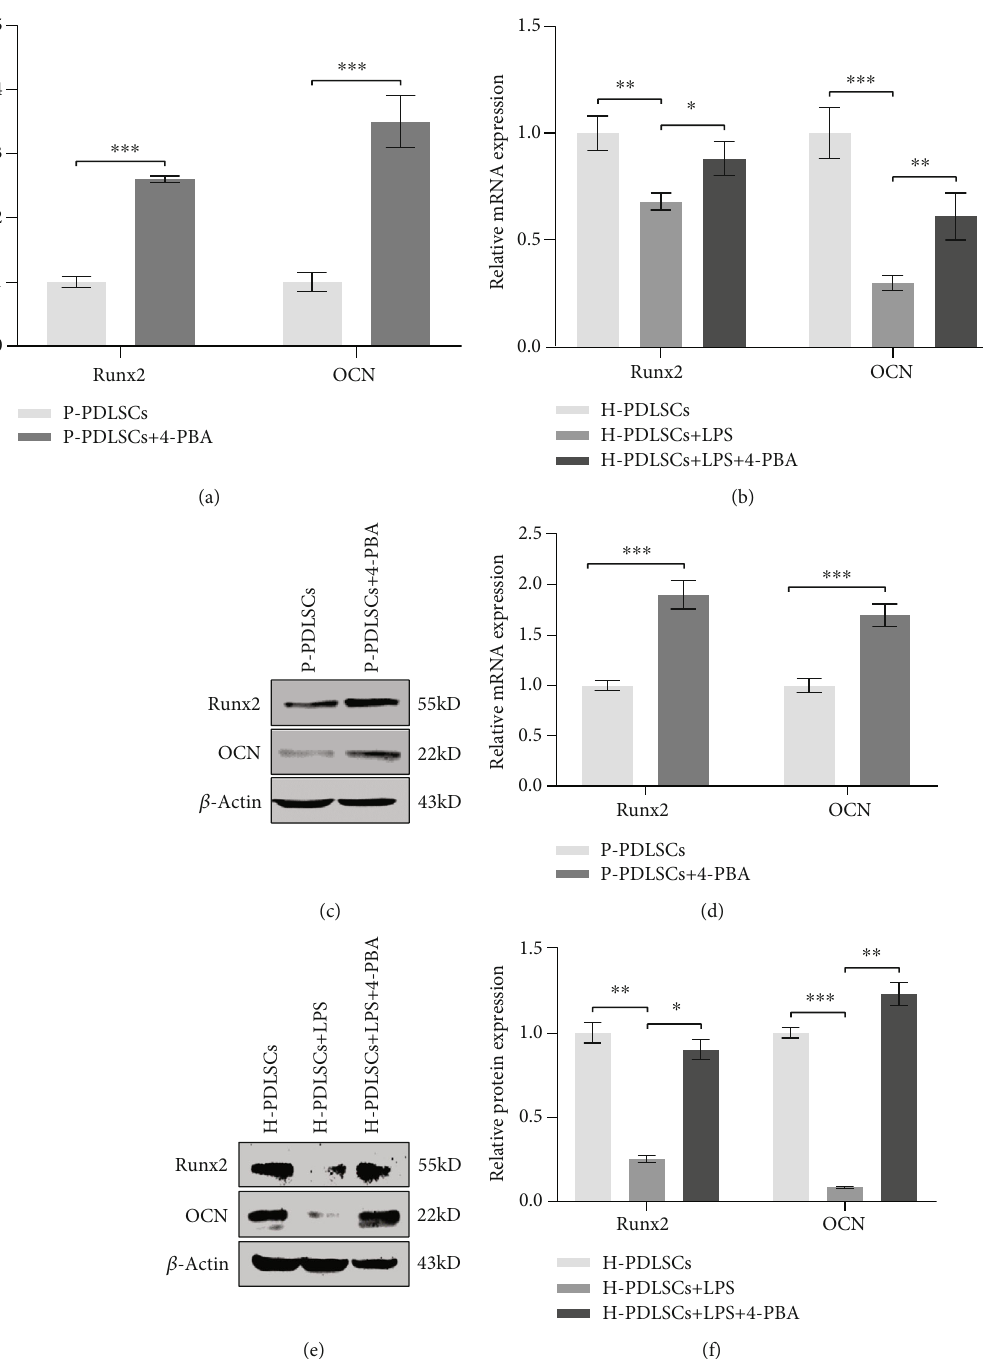
Figure 3: 4-PBA restores the impaired osteogenic di ff erentiation ability of PDLSCs in the in fl ammatory microenvironment. The mRNA and protein expression levels of Runx2 and OCN were determined by RT-qPCR after one week (a, b) and Western blot analysist after 14 days (c – f). P-PDLSCs were treated with or without 5mM 4-PBA, and H-PDLSCs treated in the absence or presence of 10 mg/l LPS or LPS in association with 5mM 4-PBA. The consequences were normalized to the GAPDH gene, and data represent mean ± standard deviations ( n = 3 ). ∗ P < 0 : 05 , ∗∗ P < 0 : 01 , ∗∗∗ P < 0 : 001